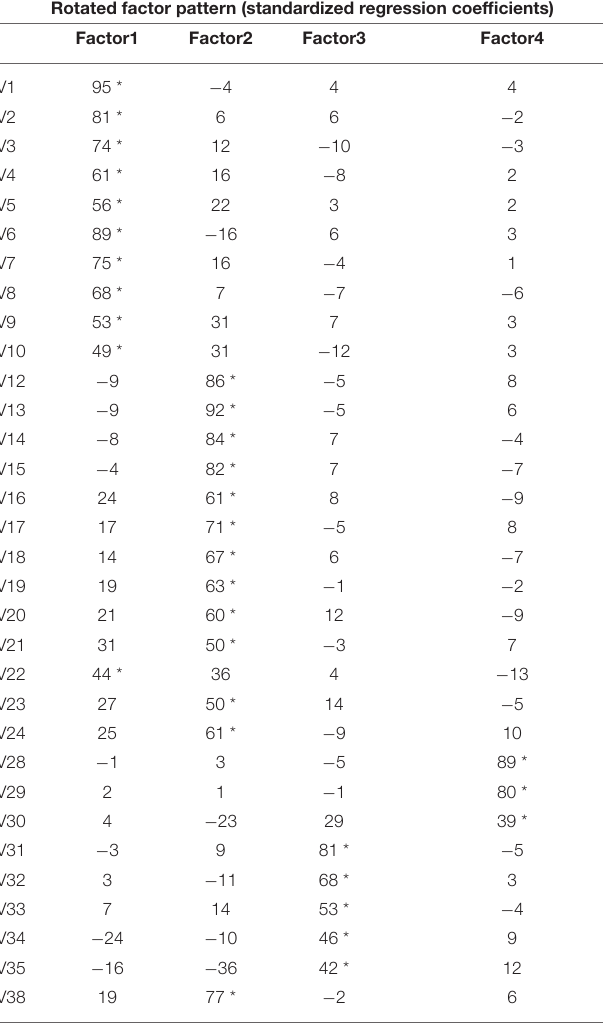
TABLE 3 | Standardized regressions coefficients in the rotated factor pattern after exploratory factor analysis (EFA). Rotated factor pattern (standardized regression